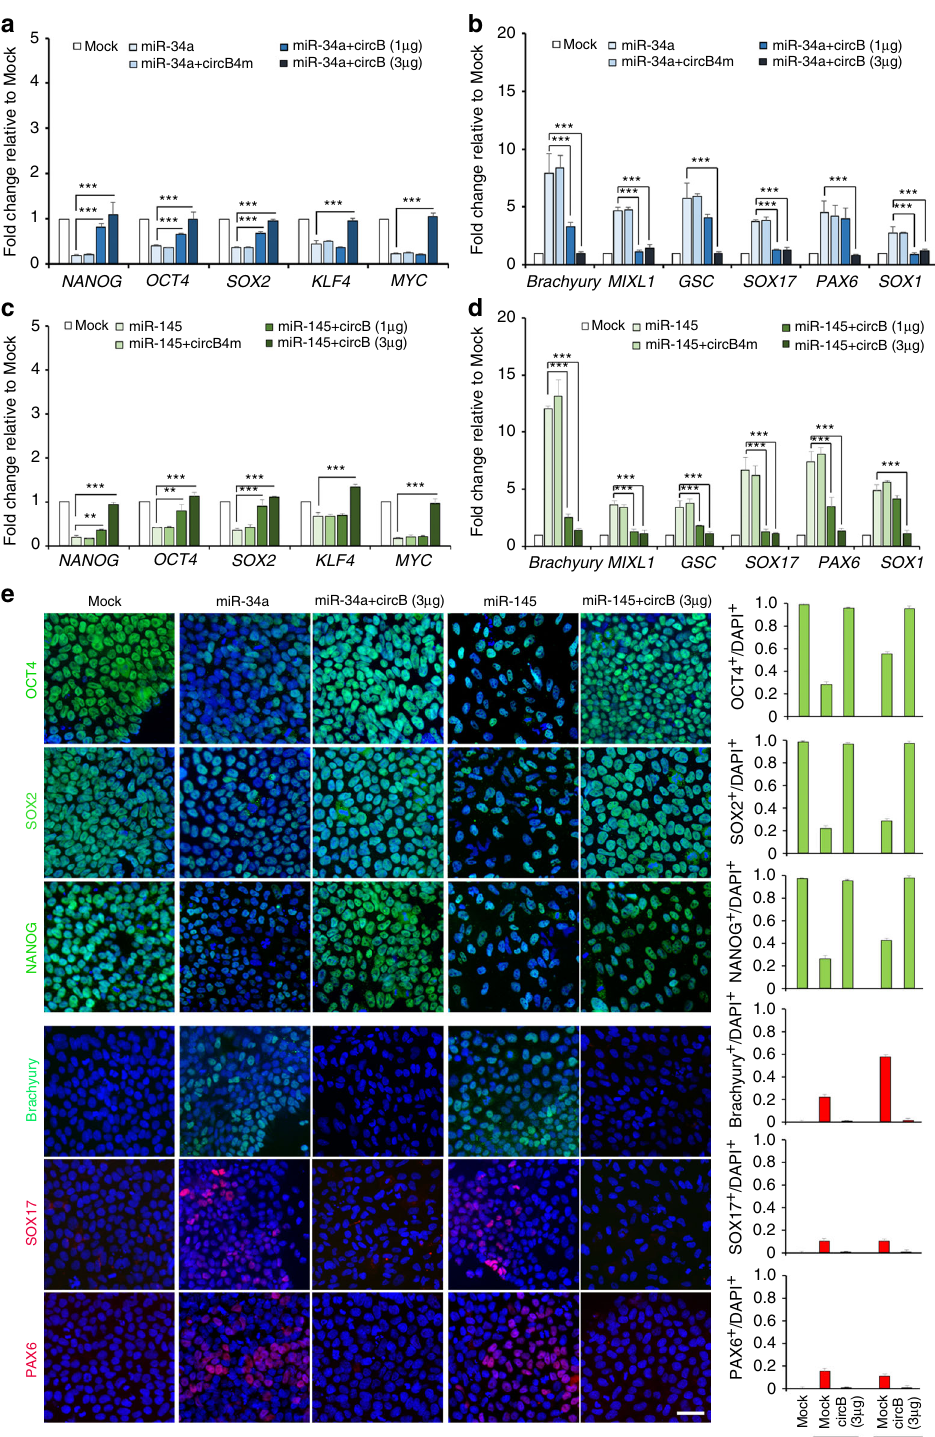
Fig. 6 CircBIRC6 serves as a sponge for miR-34a and miR-145 in hESC. a , b RT-qPCR analysis of the expression of the indicated a pluripotency-associated genes and b lineage-associated genes in hESCs transfected with miR-34a mimics, or co-transfected with circBIRC6 minigene construct (miR-34a+circB (1 μ g or 3 μ g)) or circBIRC6 minigenes harboring deleted miR-34a and miR-145 binding sites (circB4m). c , d RT-qPCR analysis of the expression of the indicated c pluripotency-associated genes and d early lineage-associated genes in hESCs transfected with miR-145 mimics, or co-transfected with circBIRC6 minigene construct (miR-145+circB (1 μ g or 3 μ g)) or co-transfected with circB4m. e ICC analysis of the indicated pluripotency-associated markers and lineage-associated markers in hESCs transfected with miR-34a or miR-145 mimics, or co-transfected with a circBIRC6 minigene construct (miR-34a+circB or miR-145+circB). Nuclei were stained with DAPI. Scale bar: 20 μ m. A quantitative analysis of cells expressing the indicated pluripotency-associated or early lineage-associated markers is shown in the right-hand panel. Quantitative data from three independent experiments is presented as mean ± SD (error bars). P -values were determined by two-tailed two-sample t -tests (* P < 0.05; ** P < 0.01; *** P <